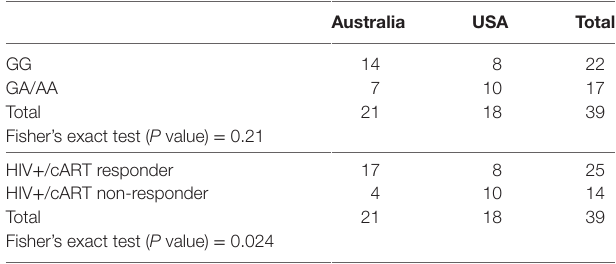
TaBle 4 | Fisher’s exact testing of country of origin against genotypes associated with the rs1385129 SLC2A1 single nucleotide polymorphism and responder and non-responder HIV + /cART groups.